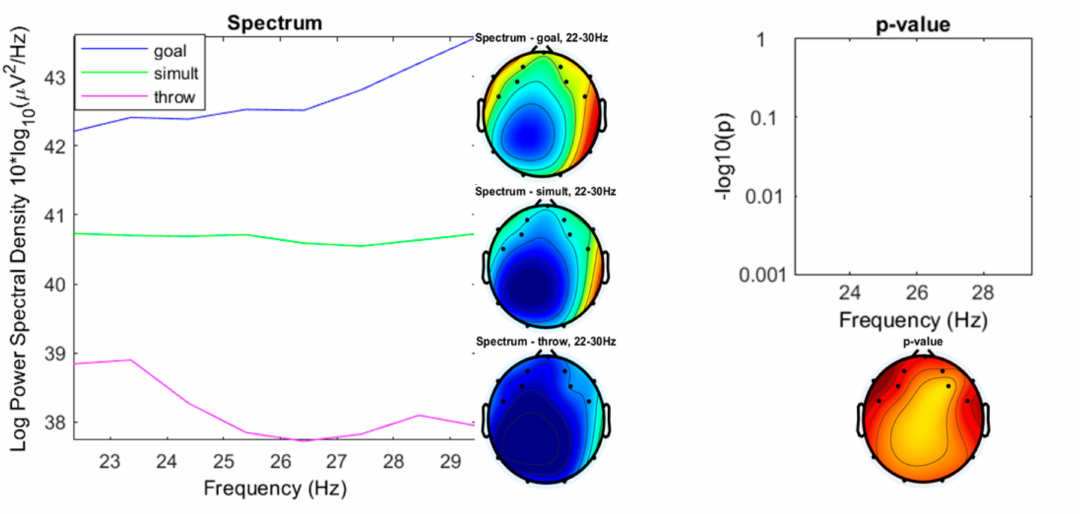
Figure 14. Spectrum plotting of the three conditions components (“throwing,” “goal,” “simultaneous”), with their plot averaged topography over frequency range, and the p -value plot for frequencies from 22 to 30 Hz